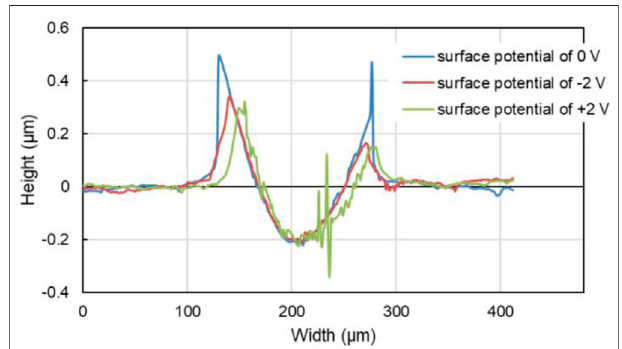
FIGURE 12 | Transverse pro fi le of the tracks on the Cu plates with different surfacepotentialduring the friction test of10 min withpure PC asthe lubricant.